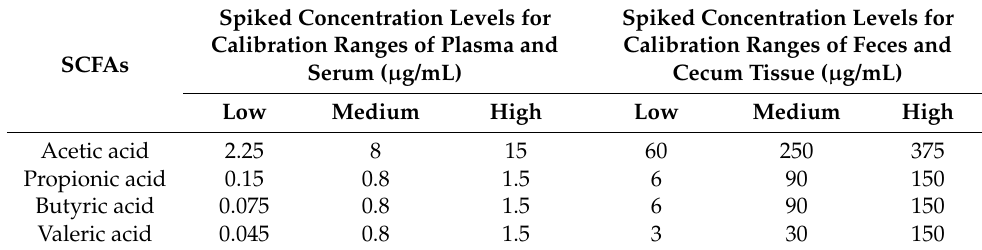
Table A2. Spiked concentration levels in each calibration